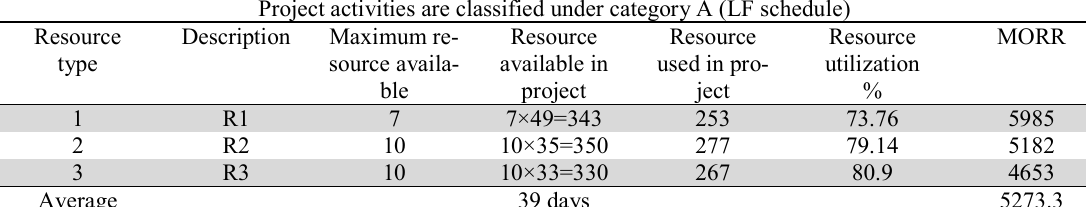
The value of the objective function obtained under LF priority rule for case 1 Project activities are classified under category A (LF schedule) Resource